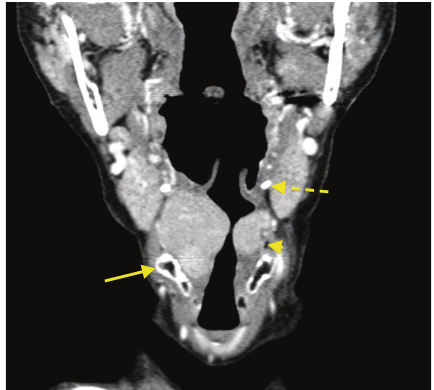
Figure 2: Both masses are medial to the thyrohyoid membrane in keeping with internal laryngoceles. Note how the pyriform sinus (arrowhead)isalmostcompletelyeffaced.Thyroidcartilage(arrow). Hyoid bone (interrupted arrow).